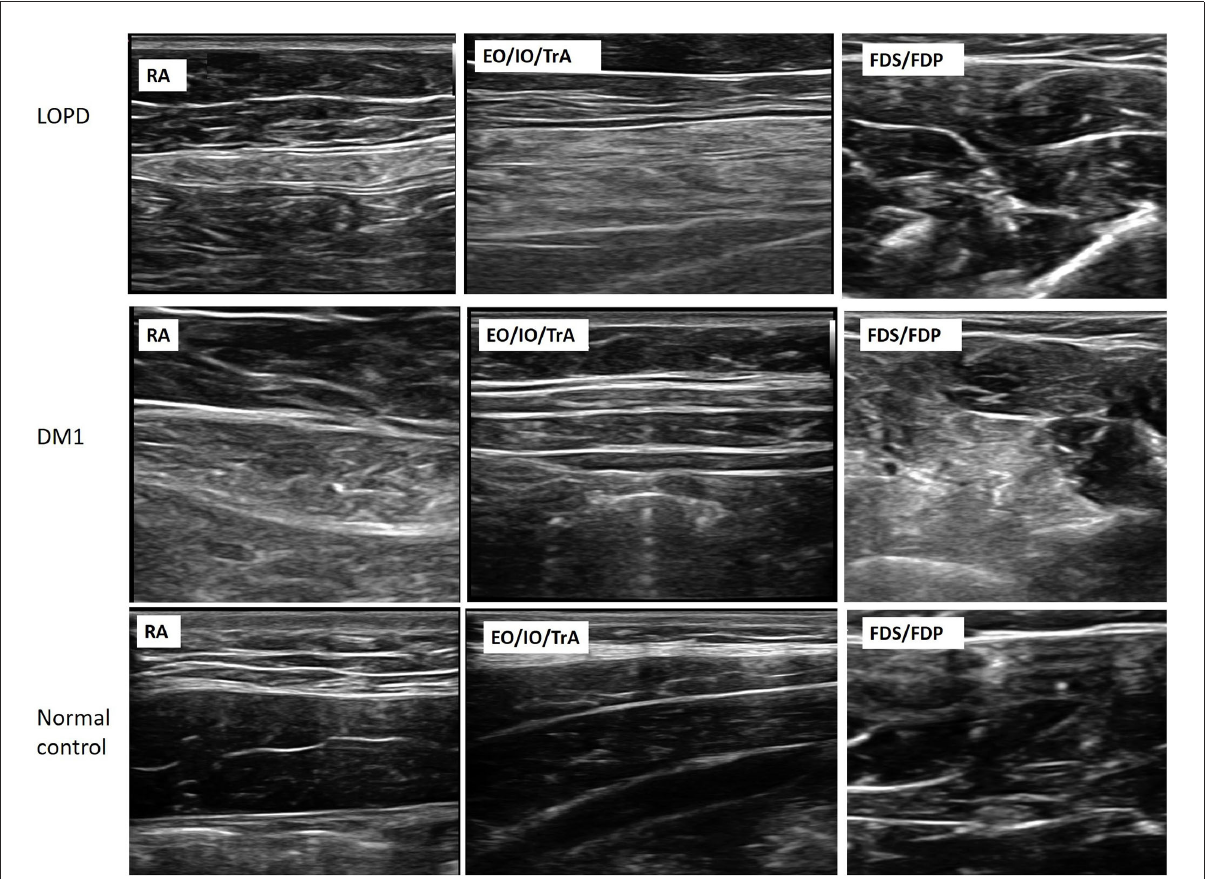
FIGURE1 Muscle ultrasonography of RA, EO/IO/TrA, and FDS/FDP muscles in the patients with LOPD, DM1, and normal controls. The images demonstrate increasing muscle echogenicity and atrophy of trunk muscles and normal echogenicity of FDS/FDP muscles in the LOPD group. For the DM1 group, the images show mildly increasing echogenicity in trunk muscles and increasing echogenicity in FDS/FDP muscles. LOPD, Late-onset Pompe disease; DM1, Myotonic dystrophy type 1; HC, Healthy control; RA, Rectus abdominis; EO, External oblique; IO, Internal oblique; TrA, Transversus abdominis; FDS/FDP, flexor digitorum superficialis/flexor digitorum